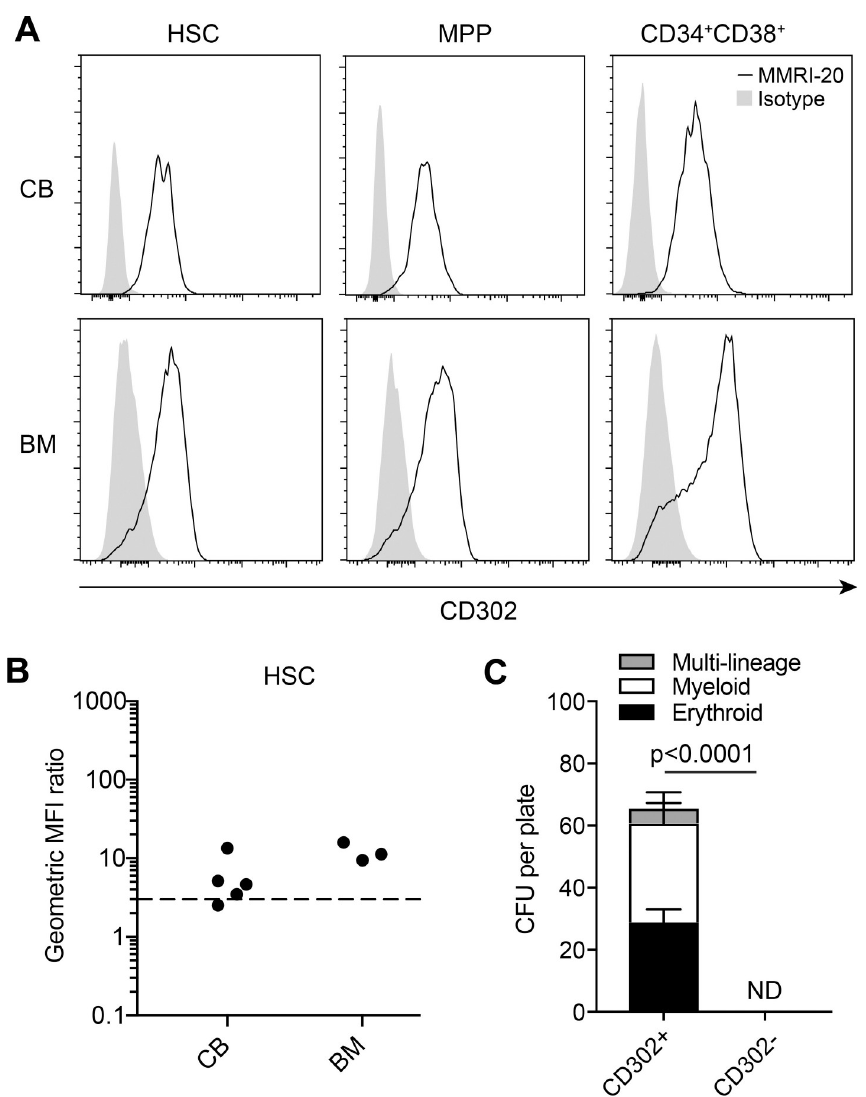
and erythroid lineages counted 12–14 days after seeding wells with equal numbers of Lin - CD302 + and CD302 - sorted CB populations (n = 6). ND, no detection of CFU